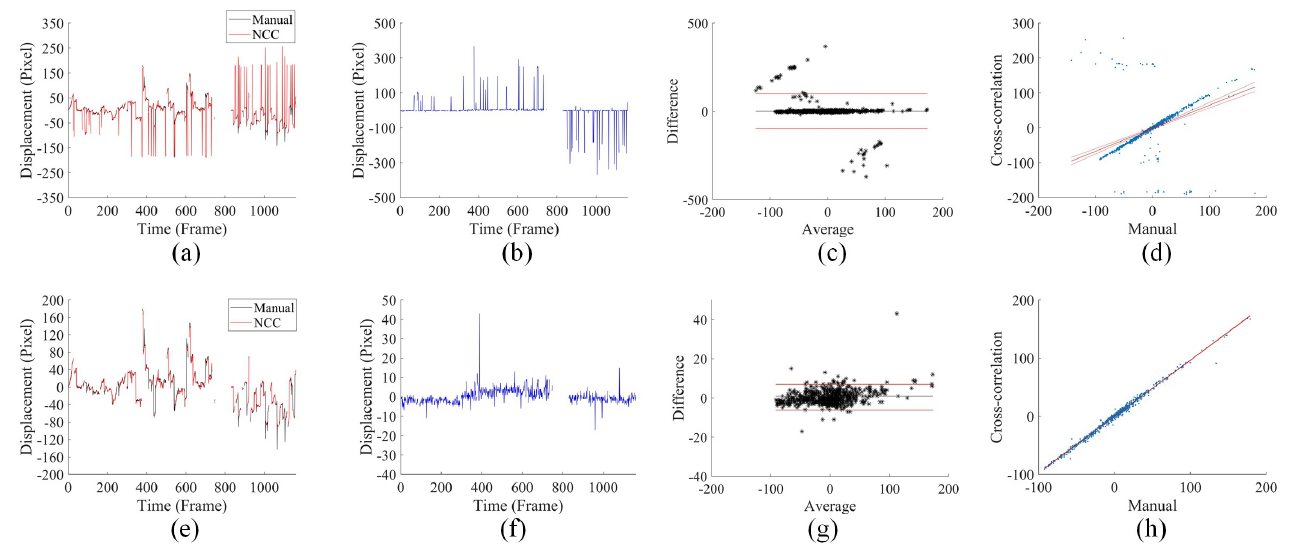
Figure 12. Horizontal displacement comparison chart; ( a ) shows the comparison of vertical displacement obtained by cross-correlation-based methods and manual registration; ( b ) is the difference between the two methods; and ( c ) is the Bland–Altman plot. The black line is the mean difference of the two methods. Red lines indicate the 95% confidence interval (mean ± 1.96 × standard deviation). The Pearson correlation coefficient curve is shown in ( d ), and ( e – h ) show the results after removal of the wrong displacement. The frame number in the x-axis corresponds to the frame number in the original video.